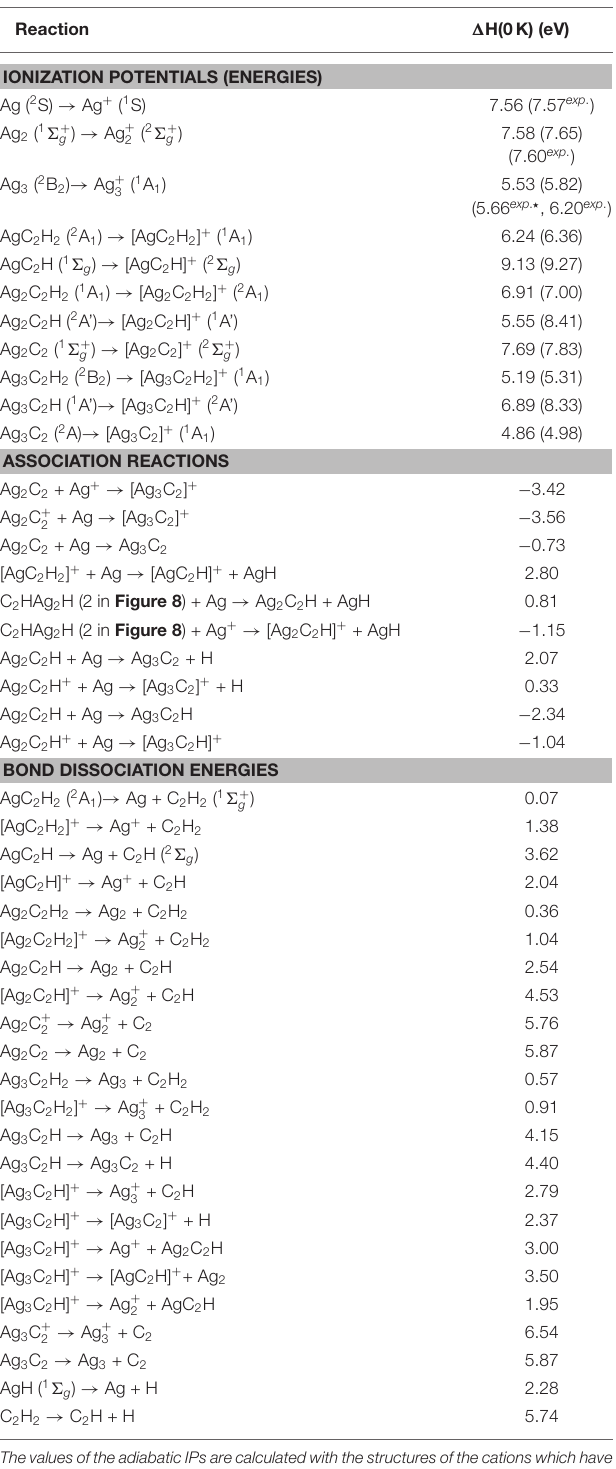
ThevaluesoftheadiabaticIPsarecalculatedwiththestructuresofthecationswhichhave been optimized, starting from those of the corresponding neutral species. Vertical IPs are indicated in parentheses. All data are obtained at the DFT level of theory. The electronic state for each complex is specified once in the table. Experimental ionization energies are retrieved from Jackschath et al. (1992) except for ⋆ which comes from Alameddin et al.